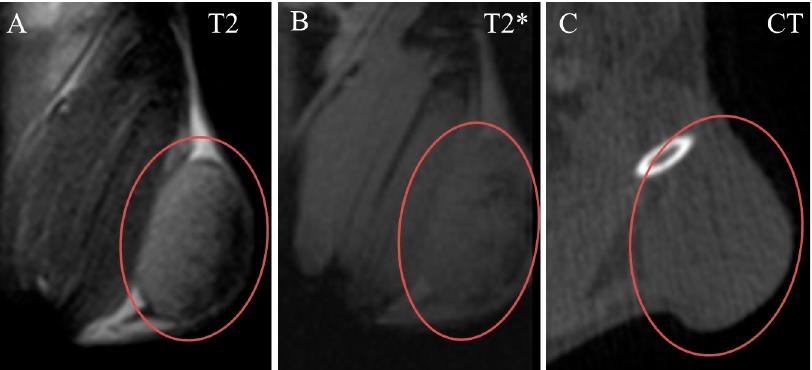
Figure 4. Native coronal images of Ca755 mammary carcinoma. ( A ) T2 MRI; ( B ) T2* MRI; ( C ) CT image. The tumor is located on the right hind leg.